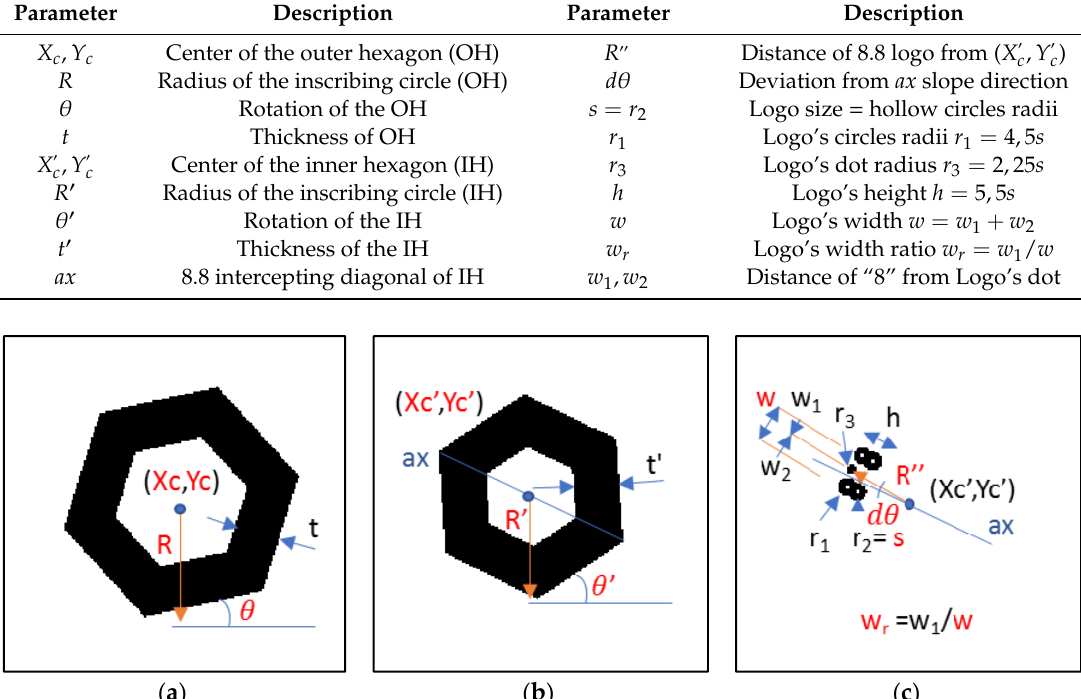
Table 1. Characteristic variables of the three parametric templates. The 13 independent variables are highlighted in red, t and t (cid:48) parameters are constants, while the other parameters are derived. Parameter Description